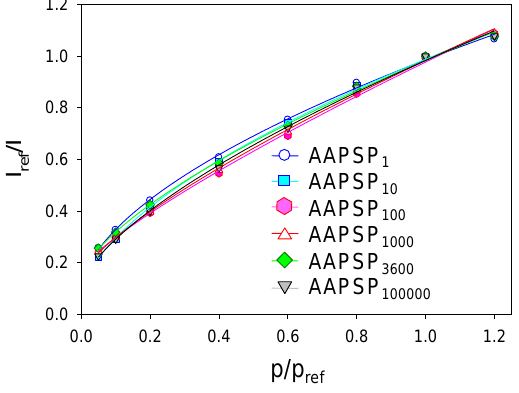
Figure 1. Pressure calibrations of AA-PSPs with varying the dipping duration.